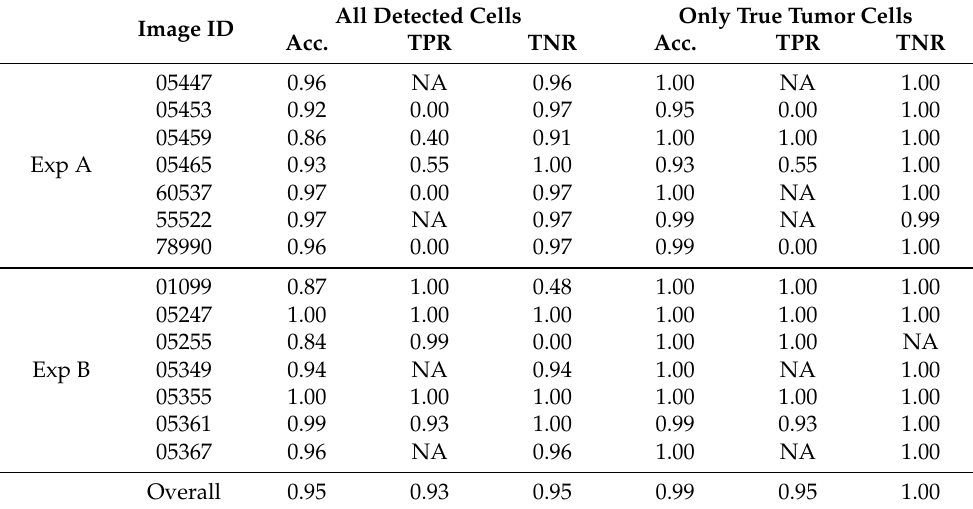
Table 5. PN classification results for 14 test images.